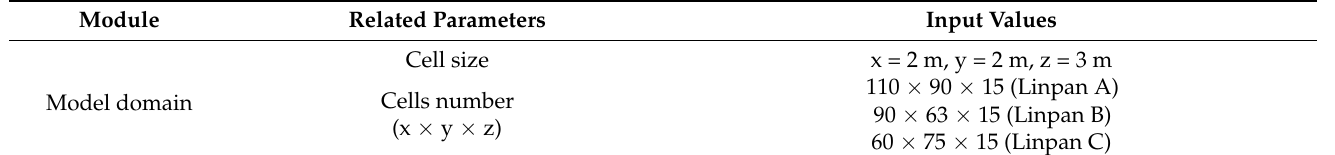
Table 3. ENVI-met simulation parameter